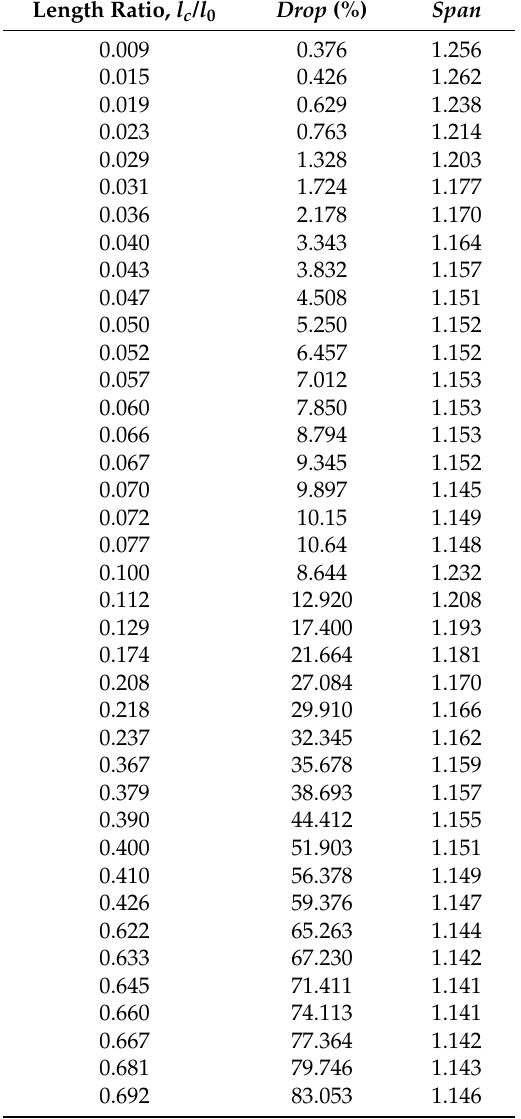
Table 2. Drop and span values vs. length ratio, l c / l 0 and depth ratio d / l 0 = −